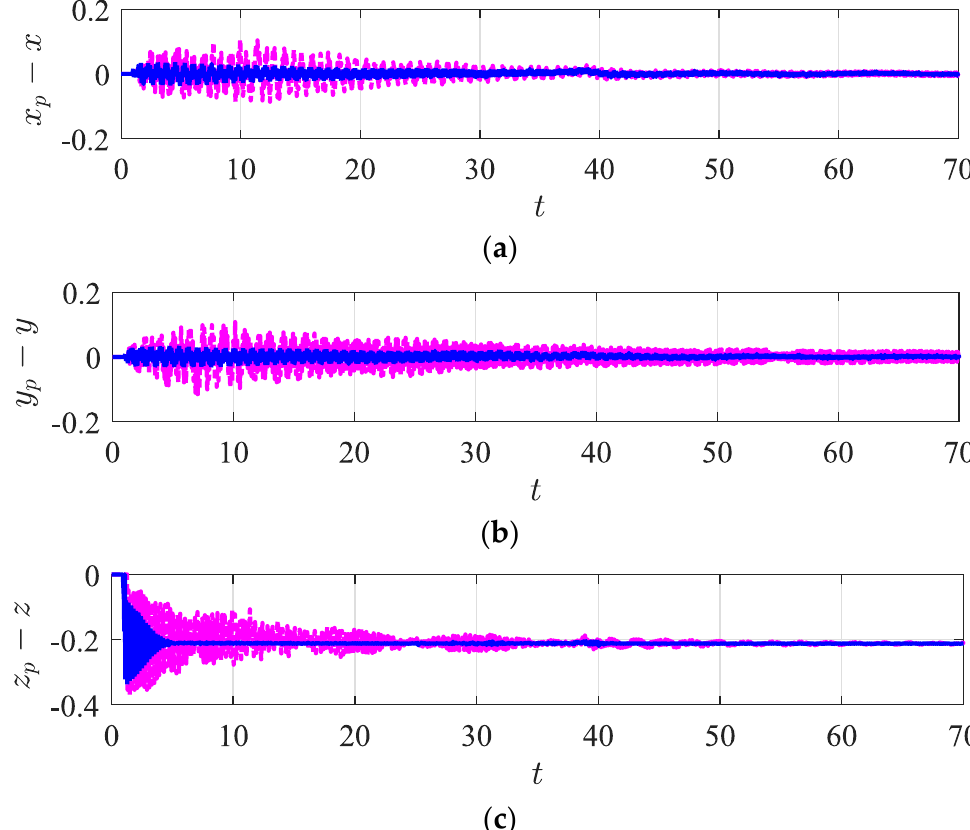
Figure 16. Relative displacements ( a ) x p − x , ( b ) y p − y and ( c ) z p − z , showing the presence (solid blue line) and absence (dashed pink line) of the chosen function in the control design.